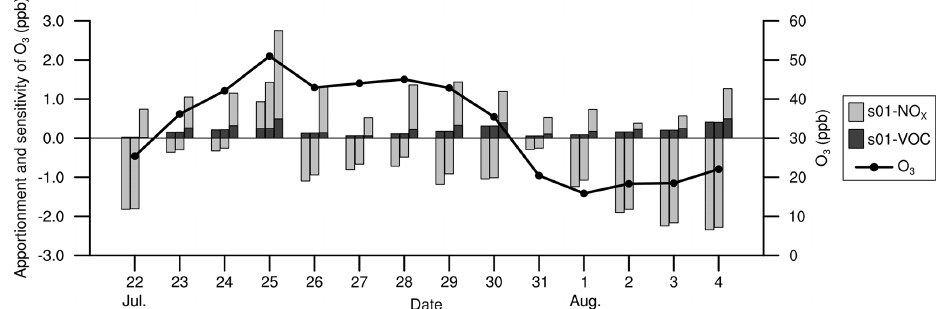
Figure 8. Sensitivities derived by BFM-20 (left) and BFM-100 (middle) and apportionments derived by ISAM (right) of daily ozone con- centrations (shown by a line with markers) to the NO x and VOC emissions of s01 for the 2 target weeks during the summer in ST.